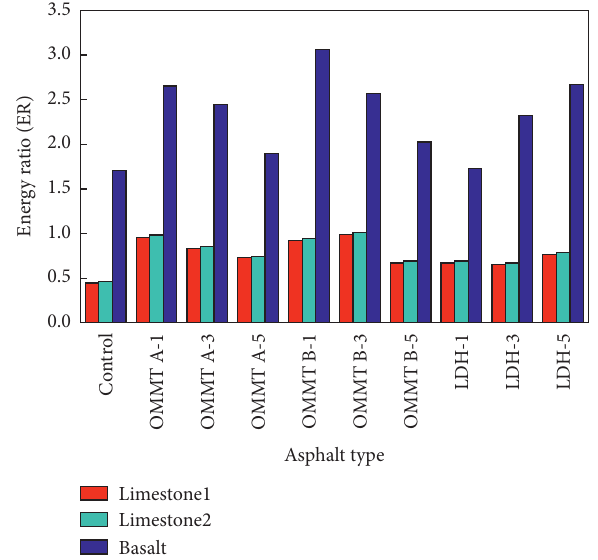
Figure 7: Energy ratios of bitumen with different types of